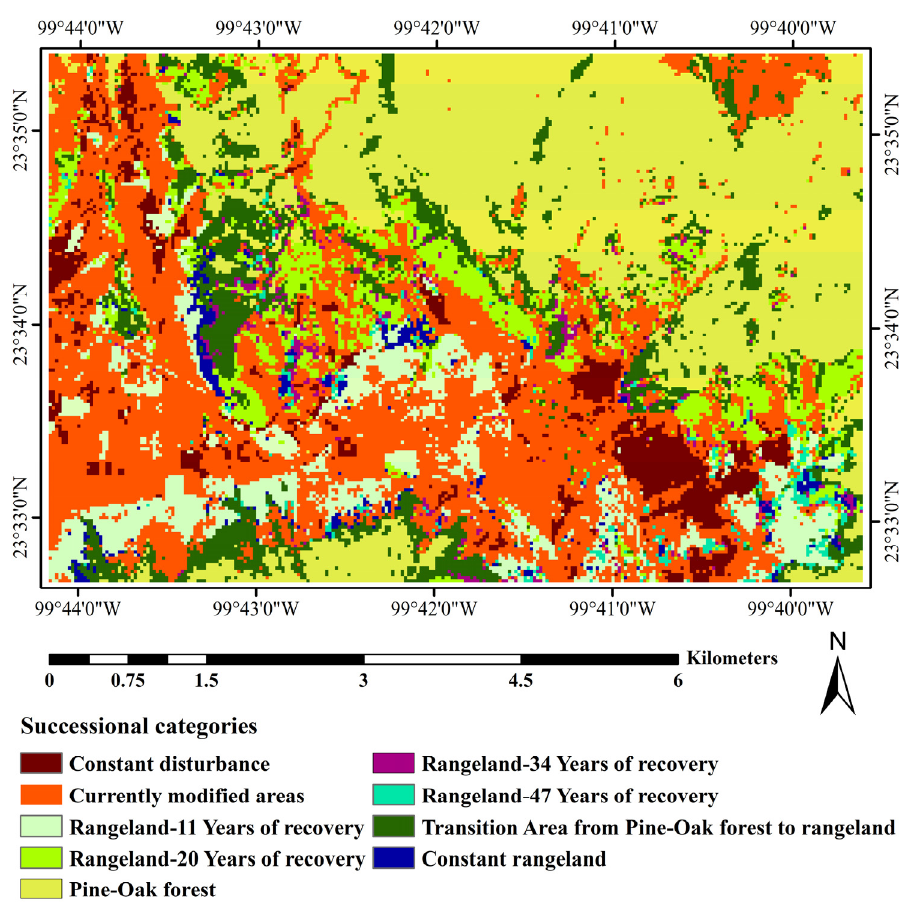
Figure 14. Successional categories of coverage and changes in land use, La Peña, Miquihuana, Tamaulipas, Mexico.